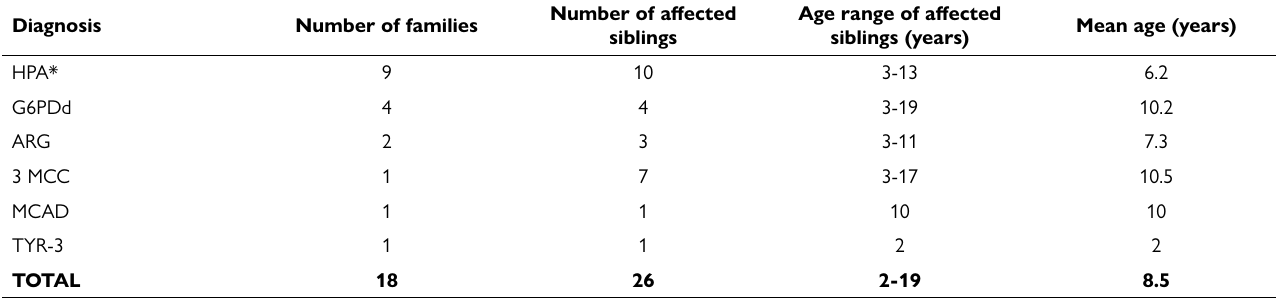
Table 1. Number of older affected siblings and their ages.